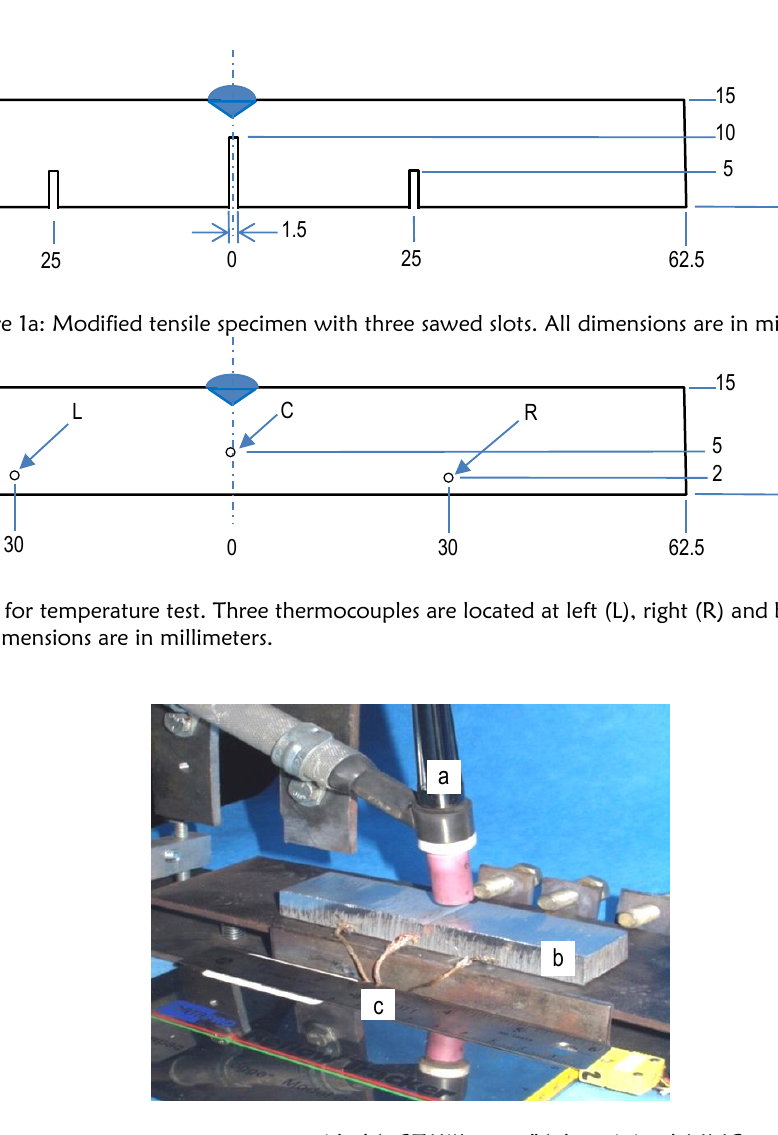
Figure 2: Welding temperature measurement with (a) GTAW gun, (b) butt joined MMC samples, and (c) three thermocouples at left, right, and below a weld